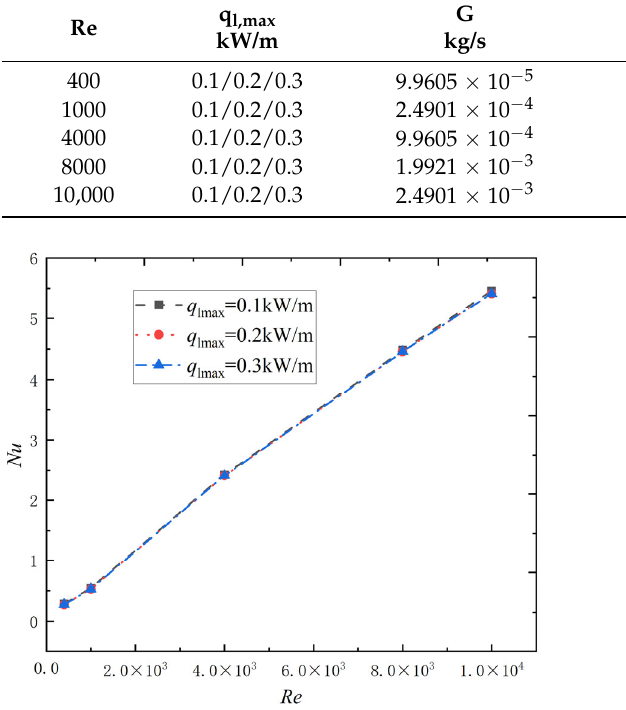
Figure 11. Variation of helium–xenon coolant convective heat transfer average Nusselt number in the channel with Re versus axial linear power density [20].